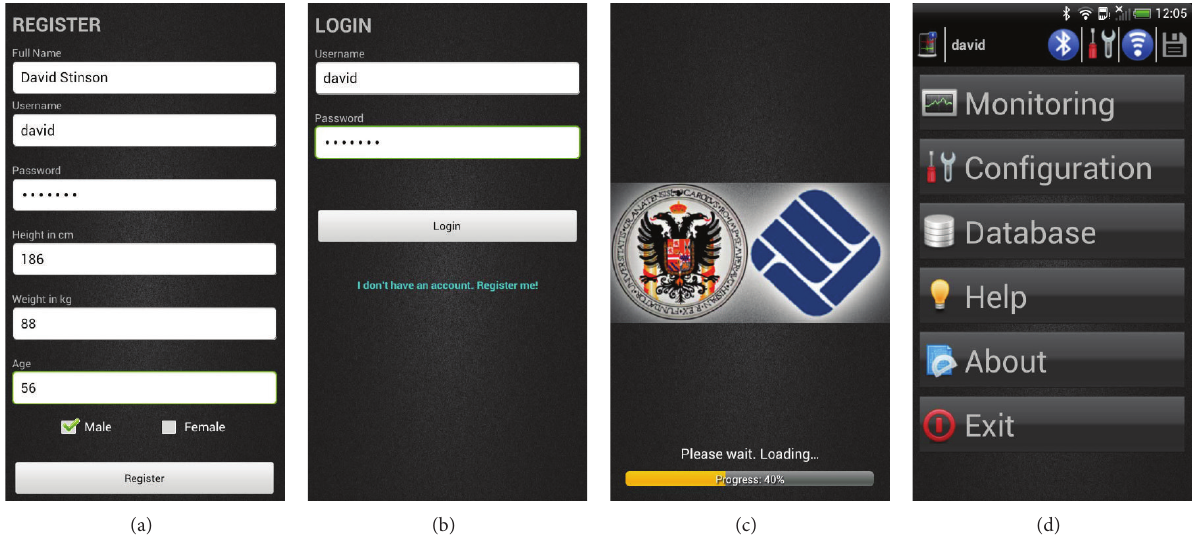
Figure 3: Screenshot from the application wizard to get started. (a) Registration. (b) Login. (c) Modules loading. (d) Main